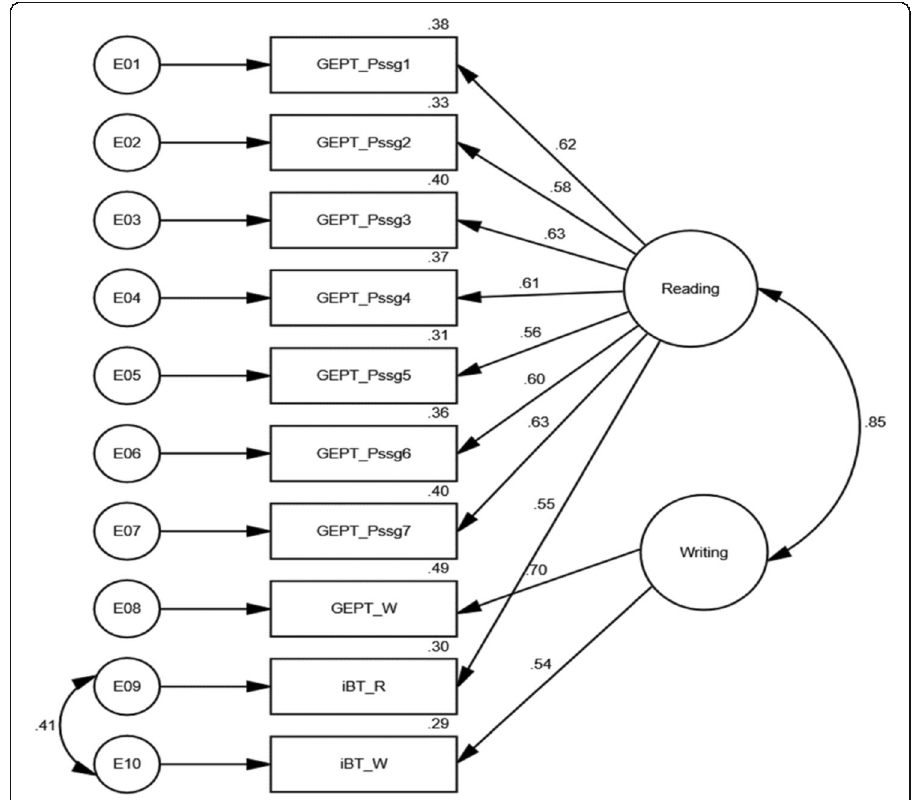
Fig. 2 Model 2a (2-Factor Reading & Writing with correlated errors), with parameter